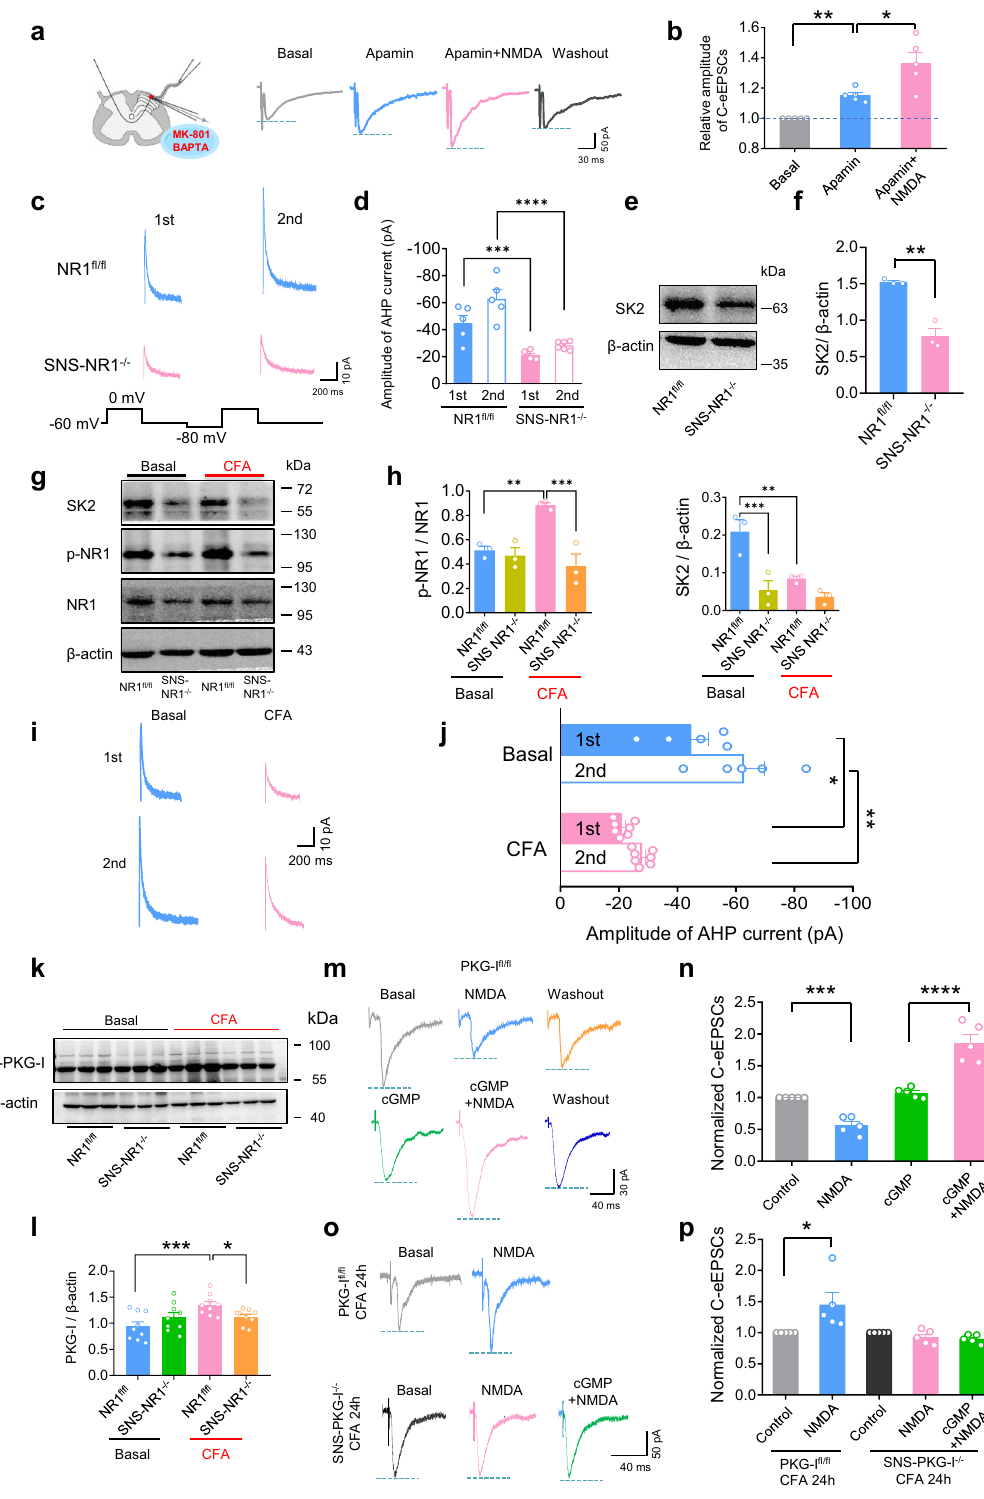
central terminals play a crucial role in the central mechanisms of secondary hypersensitivity associated with tissue injury. We utilized two models of aberrant pain which are particularly useful for studying central changes triggered initially by peripheral inputs but do not require ongoing nociceptor activity in the periphery for maintenance. Injection of capsaicin in the skin of lower thigh was able to produce a marked allodynia at the NATURE COMMUNICATIONS| (2022) 13:728